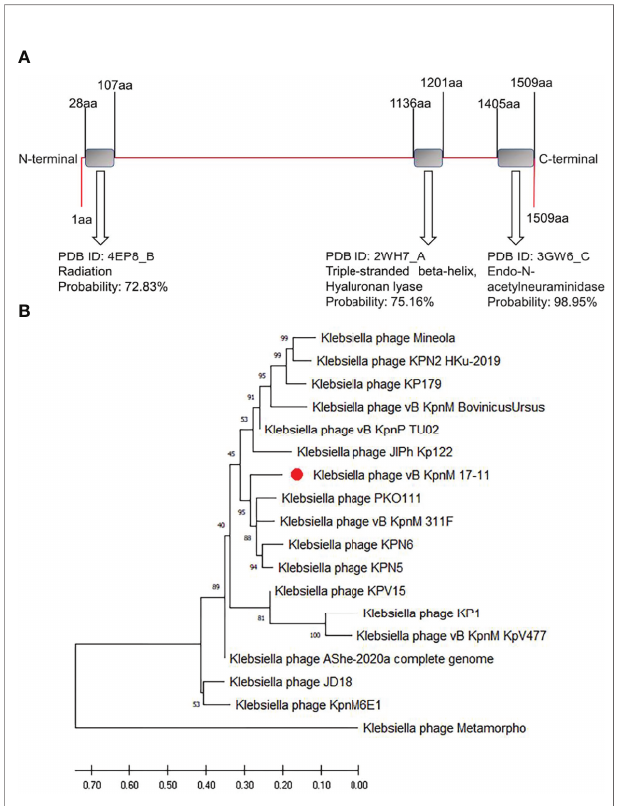
FIGURE 8 | The prediction domines and phylogenetic tree of depolymerase Dep022. (A) Domains of depolymerase Dep022 predicted using HHpred software. HHpred prediction results show that DEP022 has three different domains. (B) Phylogenetic tree of depolymerase. Phylogenic tree of depolymerases established using MEGA-X software by the neighbor-joining method with 1000 bootstrap replicates. The red dot highlights the Dep022 depolymerase of